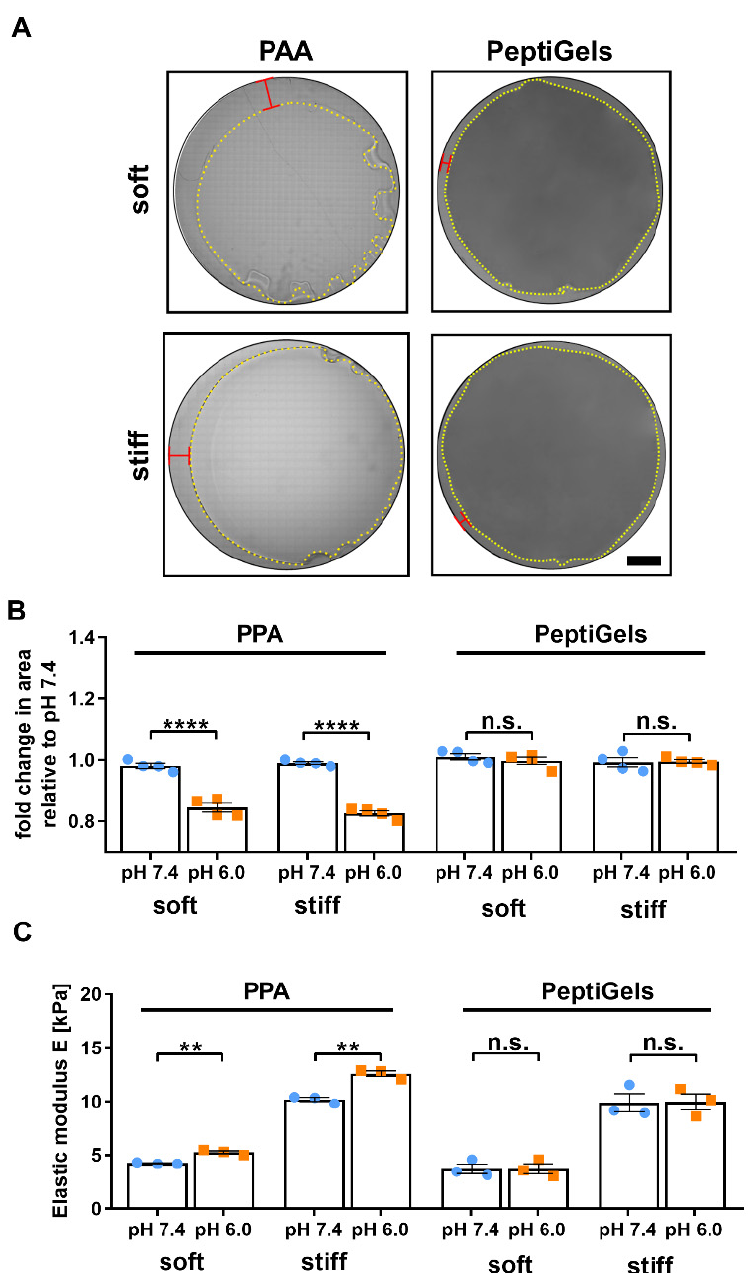
Figure 1. Polyacrylamide (PAA) gels (but not PeptiGels) shrank and changed mechanical properties at acidic pH. ( A ) Images of gels after adjusting the pH from 7.4 to 6.0. Yellow lines represent the perimeter of gels after shrinkage with red bracket indicating reduction in gel diameter. ( B ) Average change in gel area 24 h after placing samples in pH 7.4 or pH 6.0, normalized against pH 7.4 for each gel type. ( C ) Average elastic modulus across 0.1–10% strain calculated as E = 2 × G’ (1 + υ ) where, υ = Poisson’s ratio of 0.48 for PAA and 0.5 for PeptiGels. Histogram bars represent the mean ± SEM, and dots represent average value for each experimental replicate n (for ( B ) n = 4, for ( C ) n = 3, three gels measured per replicate), and the scale bar is 20 mm. Markers denote a significant difference between groups labeled with brackets by t -test; n.s.–not significant, ** 0.001 < p < 0.01 and **** p < 0.0001.